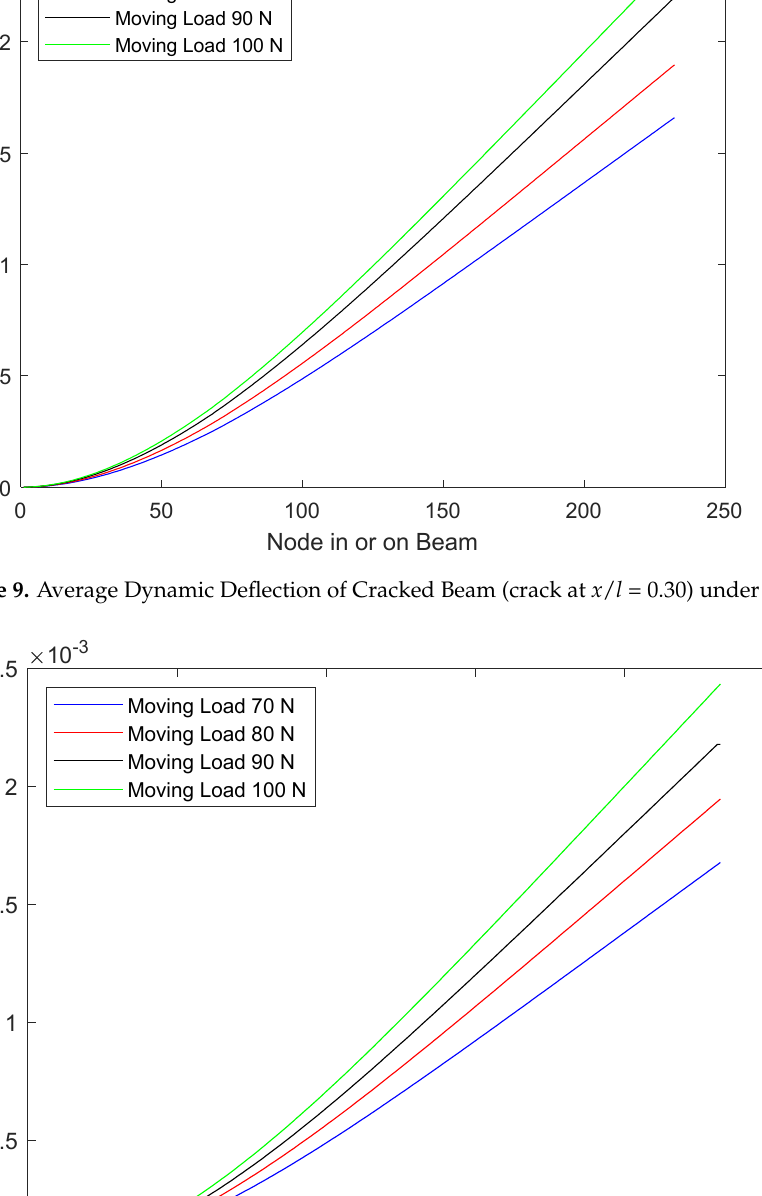
Figure 11. Average Dynamic Deflection of Cracked Beam (crack at x/l = 0.70) under moving load. It can be observed in Figures 12 and 13 that the average dynamic deflection of the uncracked beam was the lowest. However, it cannot be used to indicate the crack position in a cracked beam.